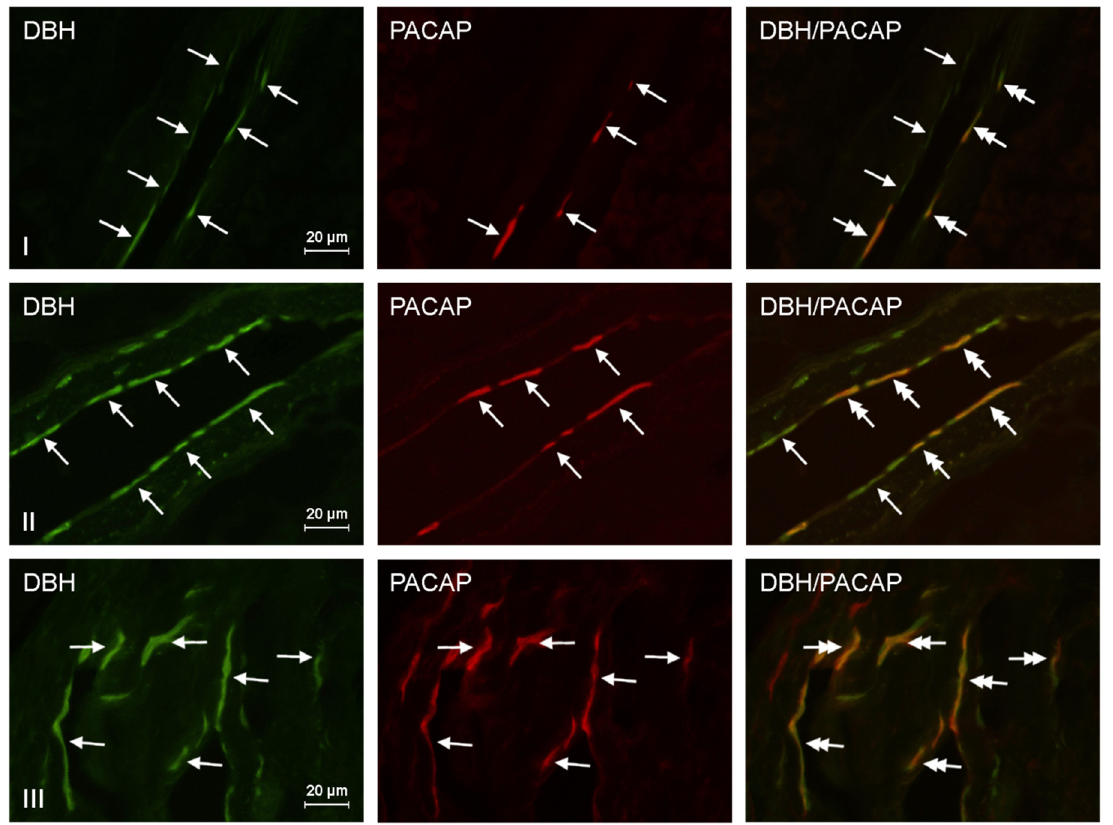
Figure 1. Representative images of the immunocytochemical localization of D β H- and PACAP-immunoreactive nerve fibers in intrahepatic sympathetic nerves (arrows) of the control group (CTRL, ( I )), experimental group 1 (E1, low dose of bisphenol A; ( II )), and experimental group 2 (E2, high dose of bisphenol A, ( III )). D β H or PACAP-IR nerve fibers are indicated with arrows; D β H and PACAP-IR nerve fibers are indicated with double-headed arrows; scale bars in all figures represent 20 µ